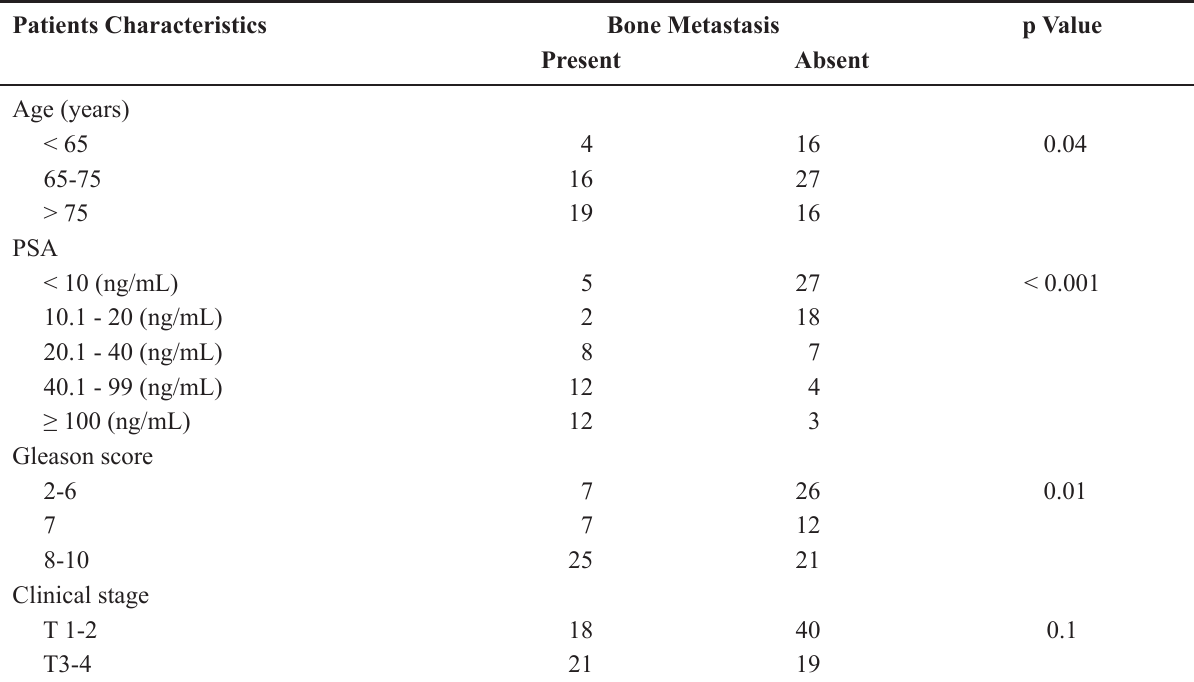
Table 1 – Demographic and clinical data in both groups of patients with prostate cancer. Patients